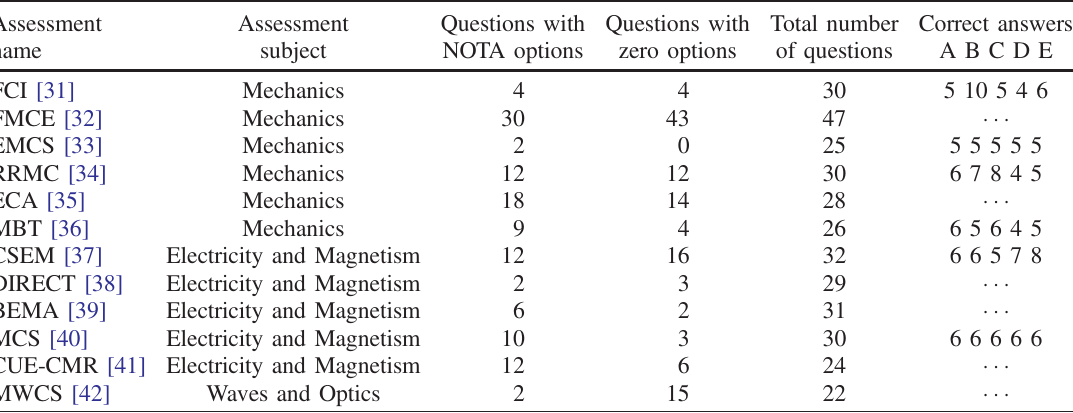
TABLE II. Comparison of the number of questions with NOTA options and zero options, as well as the distribution of correct answers for all assessments that consist solely of five-option multiple-choice